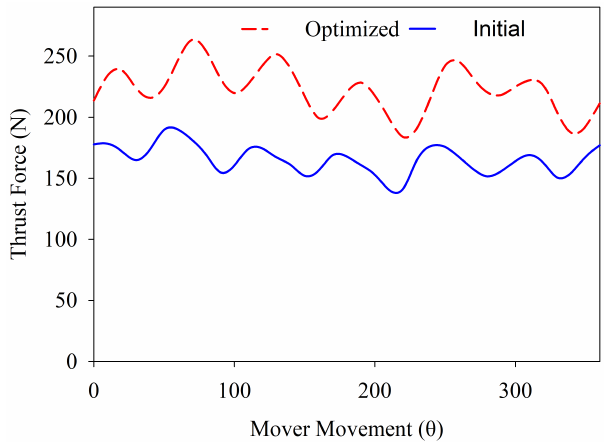
Figure 16. Thrust force of the proposed single-sided VFPMLM.